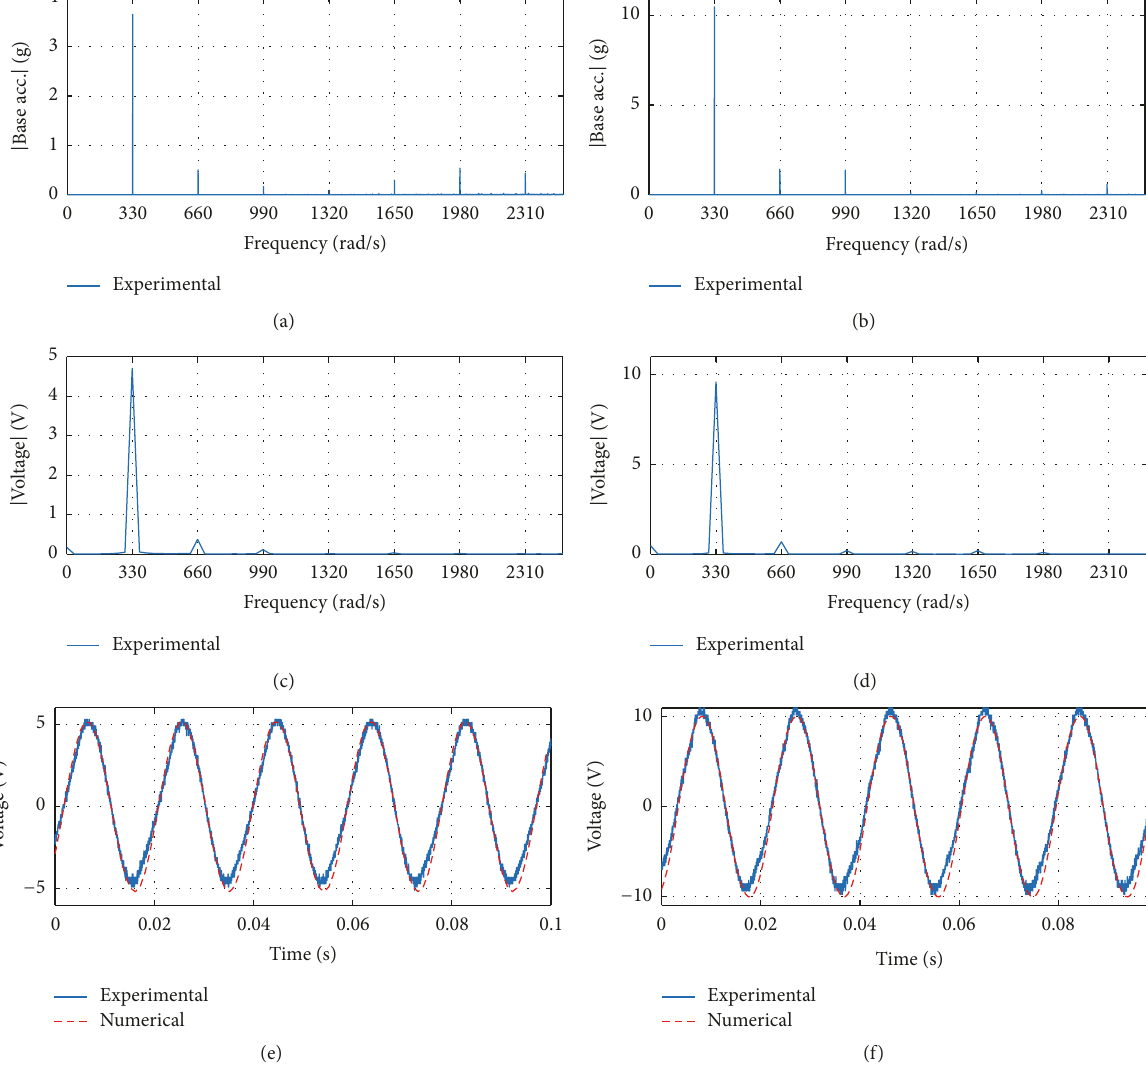
Figure 19: FFT of 3.7 𝑎 𝑔 and 10.5 𝑎 𝑔 base acceleration (a-b); FFT of the measured output voltages (c-d); comparison among experimental (solid blue lines) and numerical (dashed red lines) output voltages for 3.7 𝑎 𝑔 and 10.5 𝑎 𝑔 base acceleration